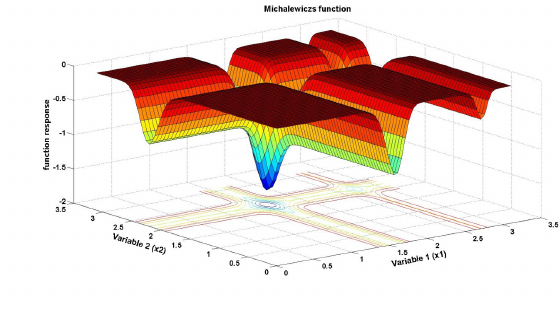
Fig. 4: Michalewiczs functions’ response for a 2-variable case.